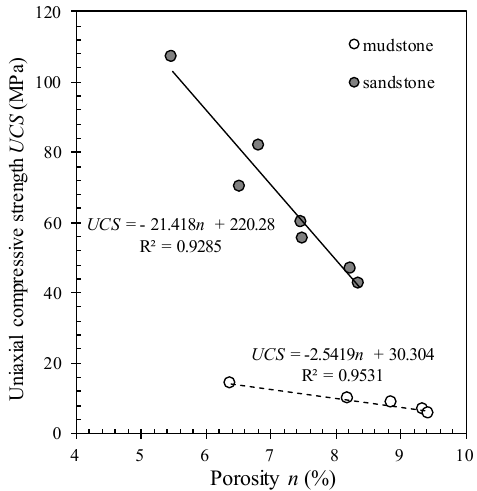
Figure 16. Relationship between the UCS and the porosity.